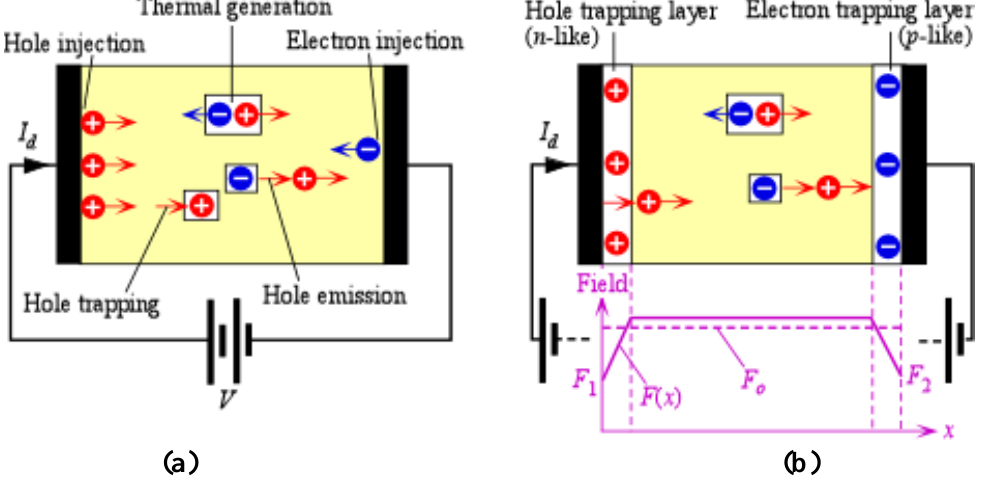
Figure 12. (a) In a single layer of a-Se sandwiched between two electrodes, the dark current is due to the injection of holes (most dominant) and electrons from the positive and negative contacts respectively as well as some thermal generation of electron and hole pairs or hole emission from defect states. (b) In the case of an x-ray photoconductor, there are two thin layers between the a-Se and the electrodes. The hole-trapping layer traps holes and allows electron transport (an n -like layer) and the electron-trapping layer traps electrons and allows hole transport (a p -like layer). The structure is often referred to as an nip type a-Se photoconductor. The radiation receiving side is the positive